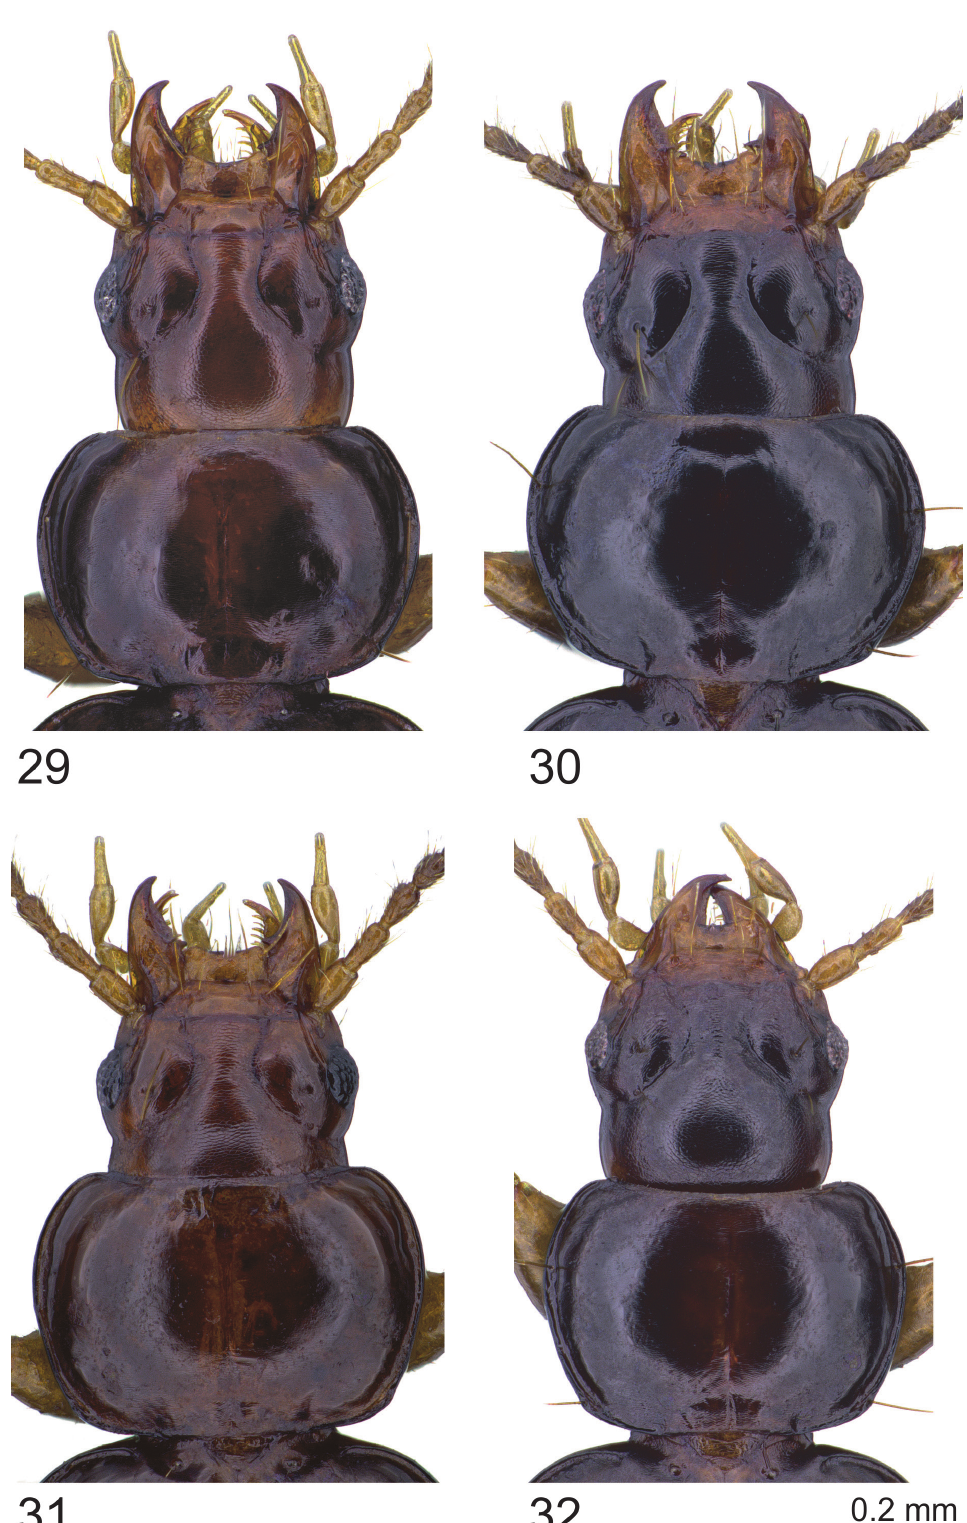
Figs 29–32. Trechus spp., head, pronotum. 29 . T. dodola sp. nov., holotype. 30 . T. adaba sp. nov., paratype, ♂. 31 . T. harryi sp. nov., paratype, ♂. 32 . T. harenna sp. nov., paratype,